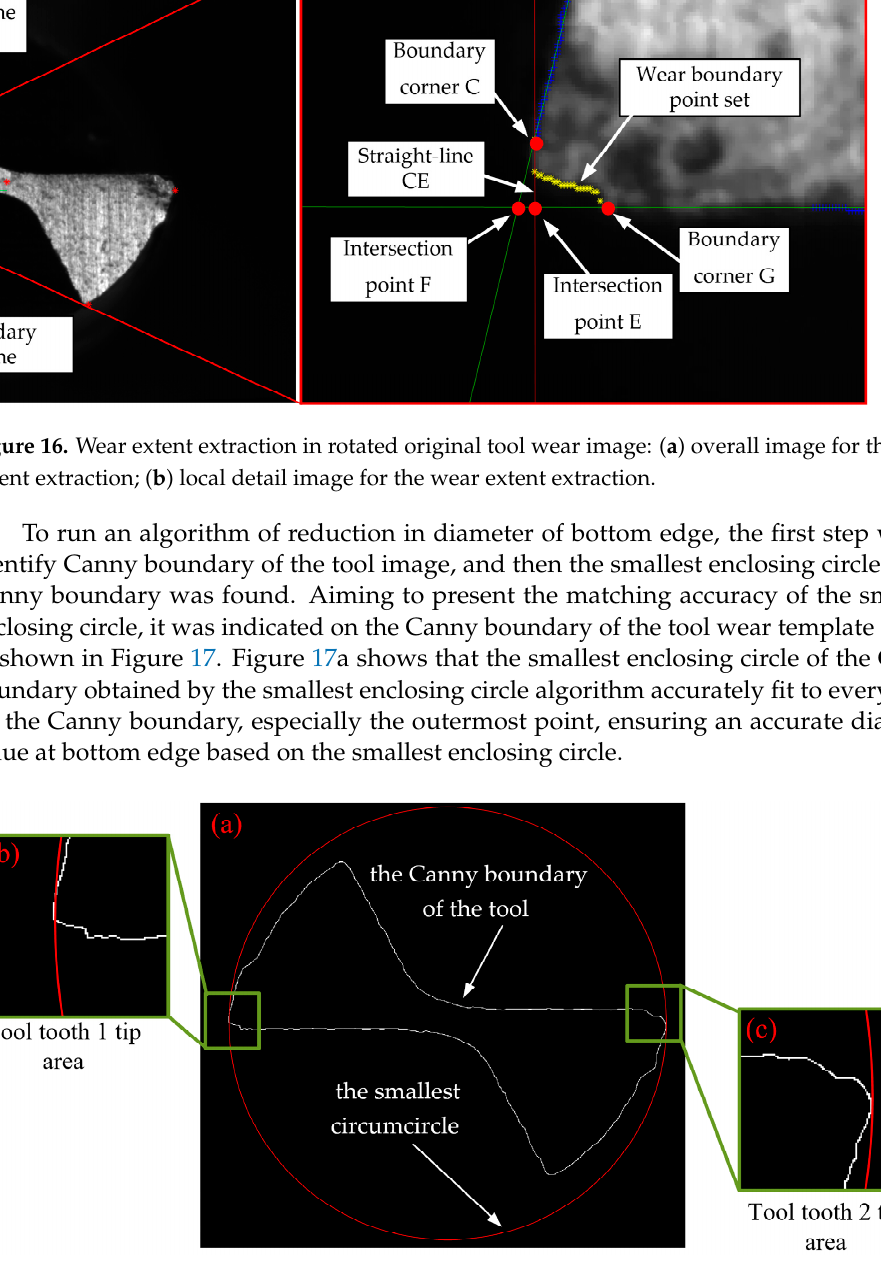
Figure 17. Smallest enclosing circle algorithm in the Canny boundary image: ( a ) boundary extracted by Canny edge detector with the smallest circumcircle shown in the Canny boundary image; ( b ) the detail of tool tooth 1 tip area; ( c ) the detail of tool tooth 2 tip area.